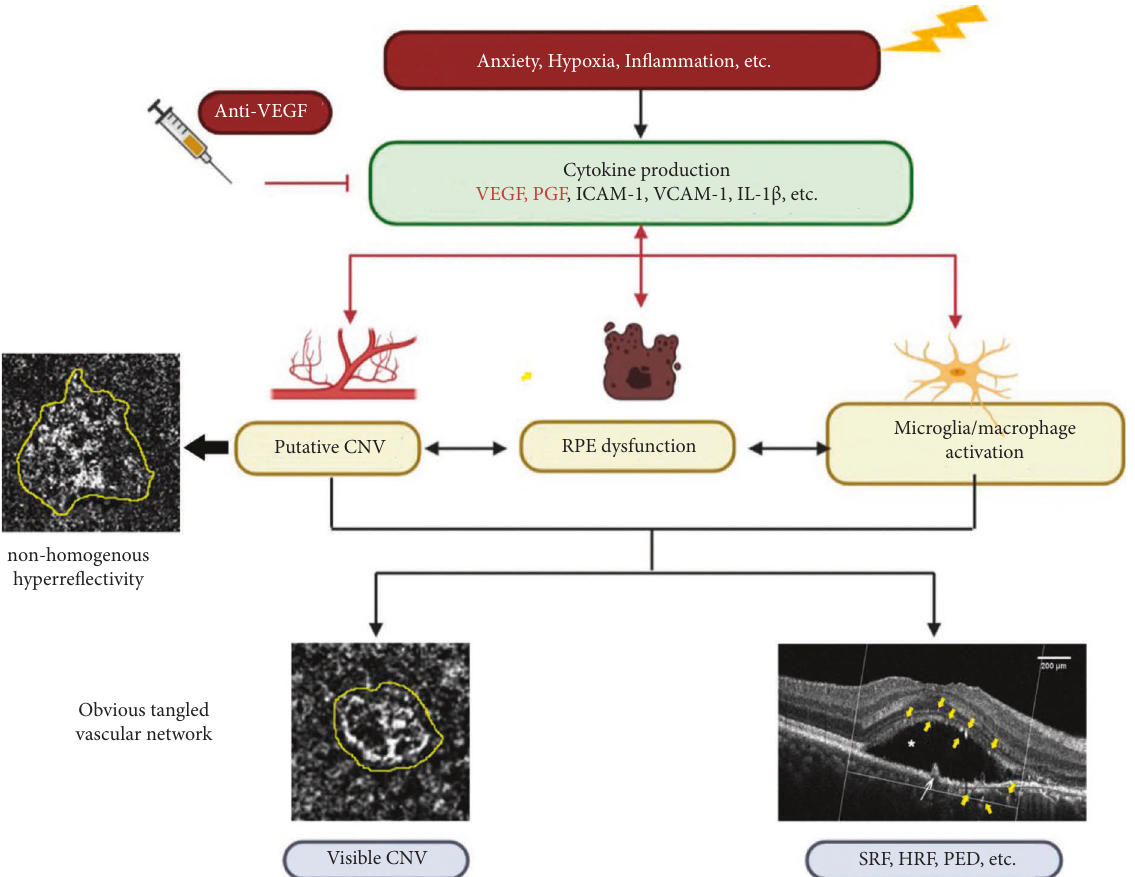
Figure 8: Schematic diagram depicting the progression and potential mechanism of CSCR coexisting putative or visible CNV and the possible effect of anti-VEGF treatment. CNV, choroidal neovascularization; CSCR, central serous chorioretinopathy; HRF, hyperreflective foci (yellow arrow); ICAM-1, intercellular cell adhesion molecule-1; PGF, placental growth factor; RPE, retinal pigment epithelium; SRF, subretinal fluid (asterisk); PED, pigment epithelial detachment (white arrow); VCAM-1, vascular cell adhesion molecule-1; VEGF, vascular endothelial growth factor. The putative CNV and visible CNV were circled with dotted yellow circle on the choriocapillaris layer in